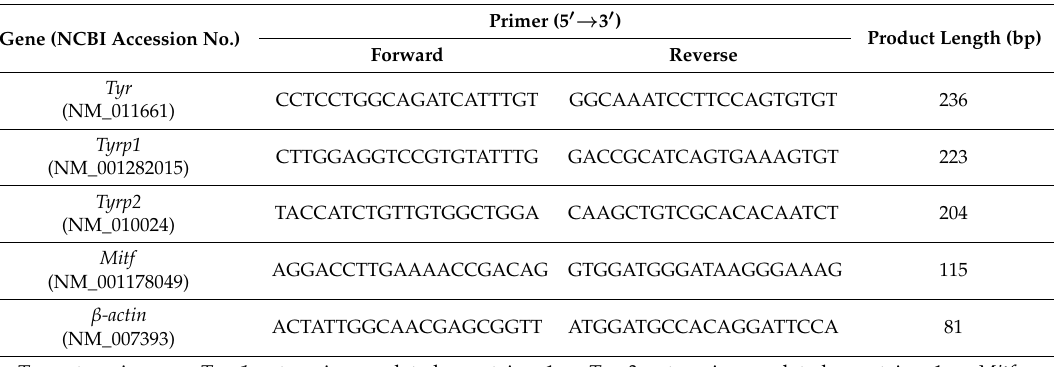
Table 1. Primer sets for real-time